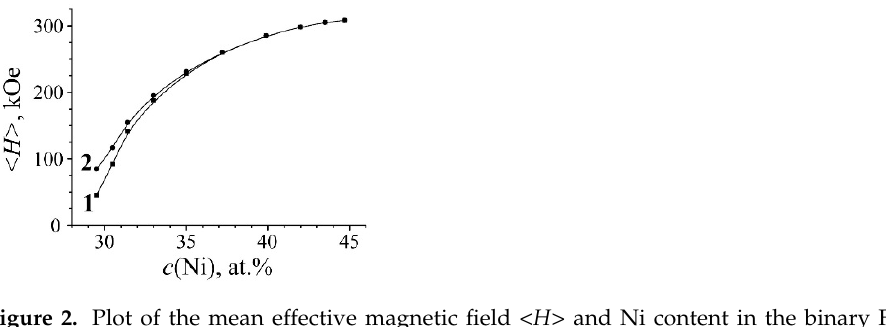
Figure 2. Plot of the mean effective magnetic field < H > and Ni content in the binary Fe–Ni al- loys. Curve 1—< H > for the bulk spectrum; curve 2—< H > for the spectrum without the central component γ 1